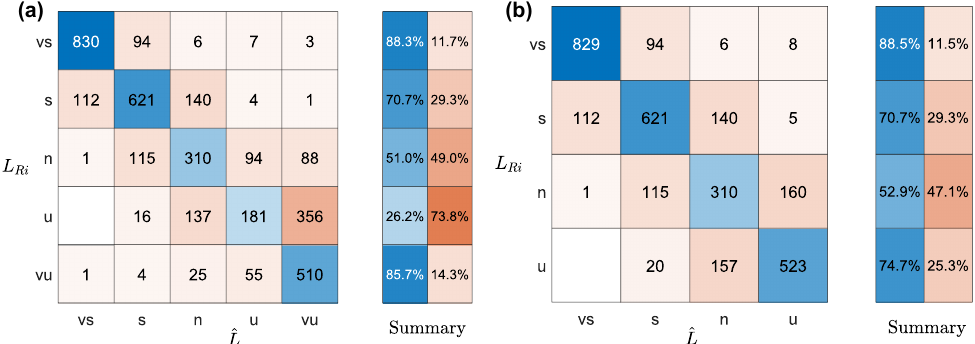
Figure 15. Confusion matrix between ˆ L and L Ri for Van Wijk’s stability classes (Table 2) in the same format as in Figure